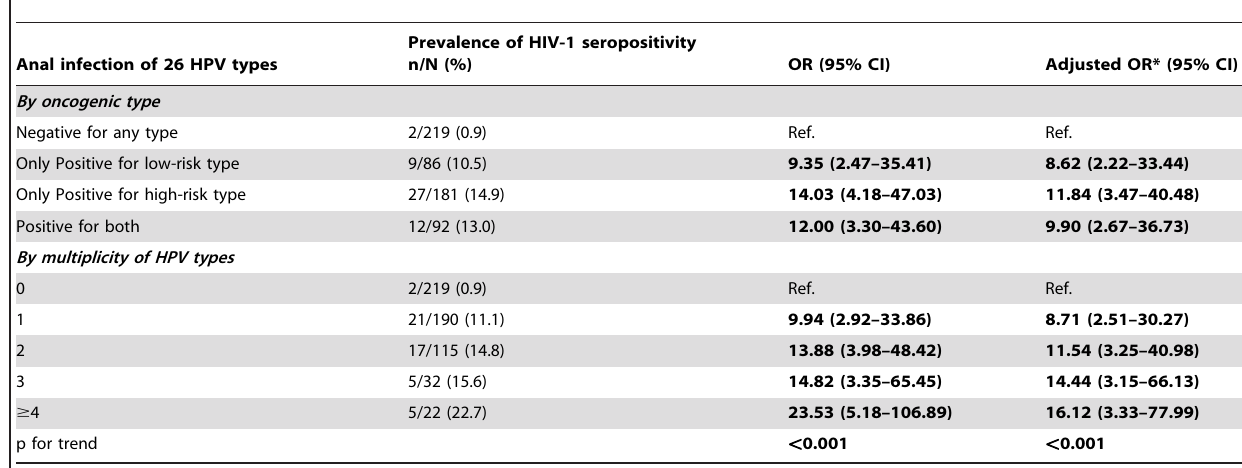
Table 3. The association of anal HPV infection with HIV-1 seropositivity by oncogenic type and multiplicity of HPV types.